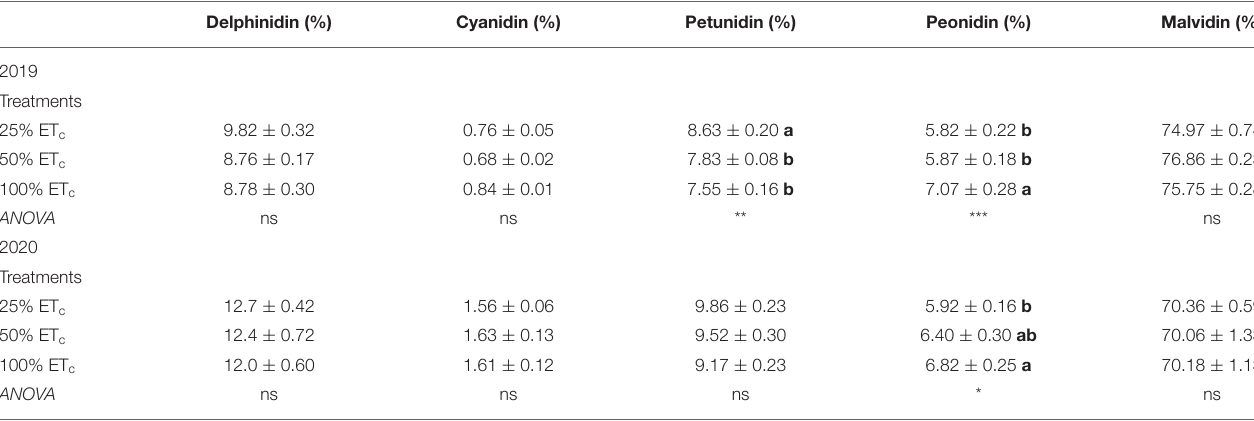
TABLE 3 | Anthocyanin composition (%) of Cabernet Sauvignon grapevines (clone FPS08) subjected to different replacement of crop evapotranspiration (25, 50, and 100% ET c ), collected at harvest in Oakville, CA, in 2018–2019 and 2019–2020